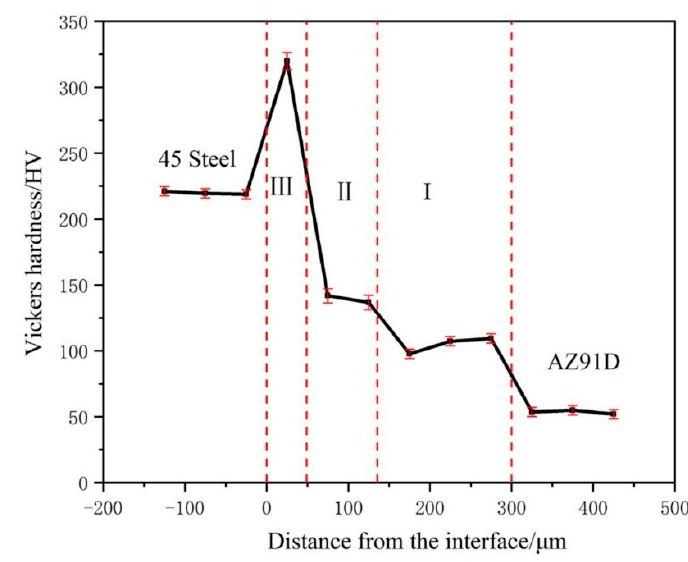
Figure 13. Microhardness distributions at the galvanized-steel / AZ91D compound interface.